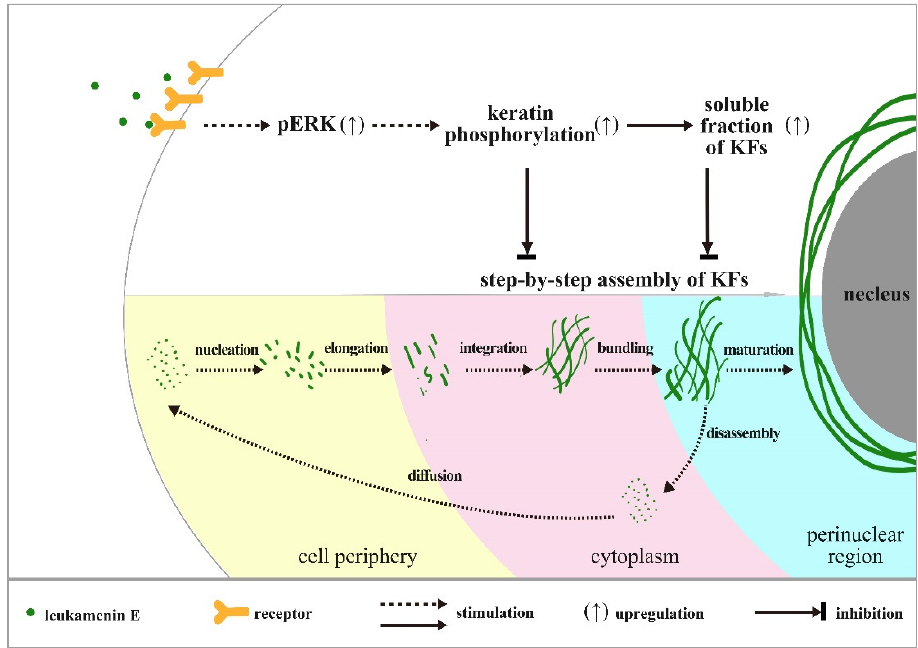
Figure 10. Working Model. Our data are consistent with a model in which leukamenin E-induced phosphorylation at K8-Ser73/431 and K18-Ser52 was involved in increased soluble fraction of KFs and altered polymerization. Leukamenin E may interfere with initiation of KFs assembly at the periphery of the cell and block step-by-step assembly of KFs and the formation of a new KFs network and then inhibit turnover of KFs in HUVECs.